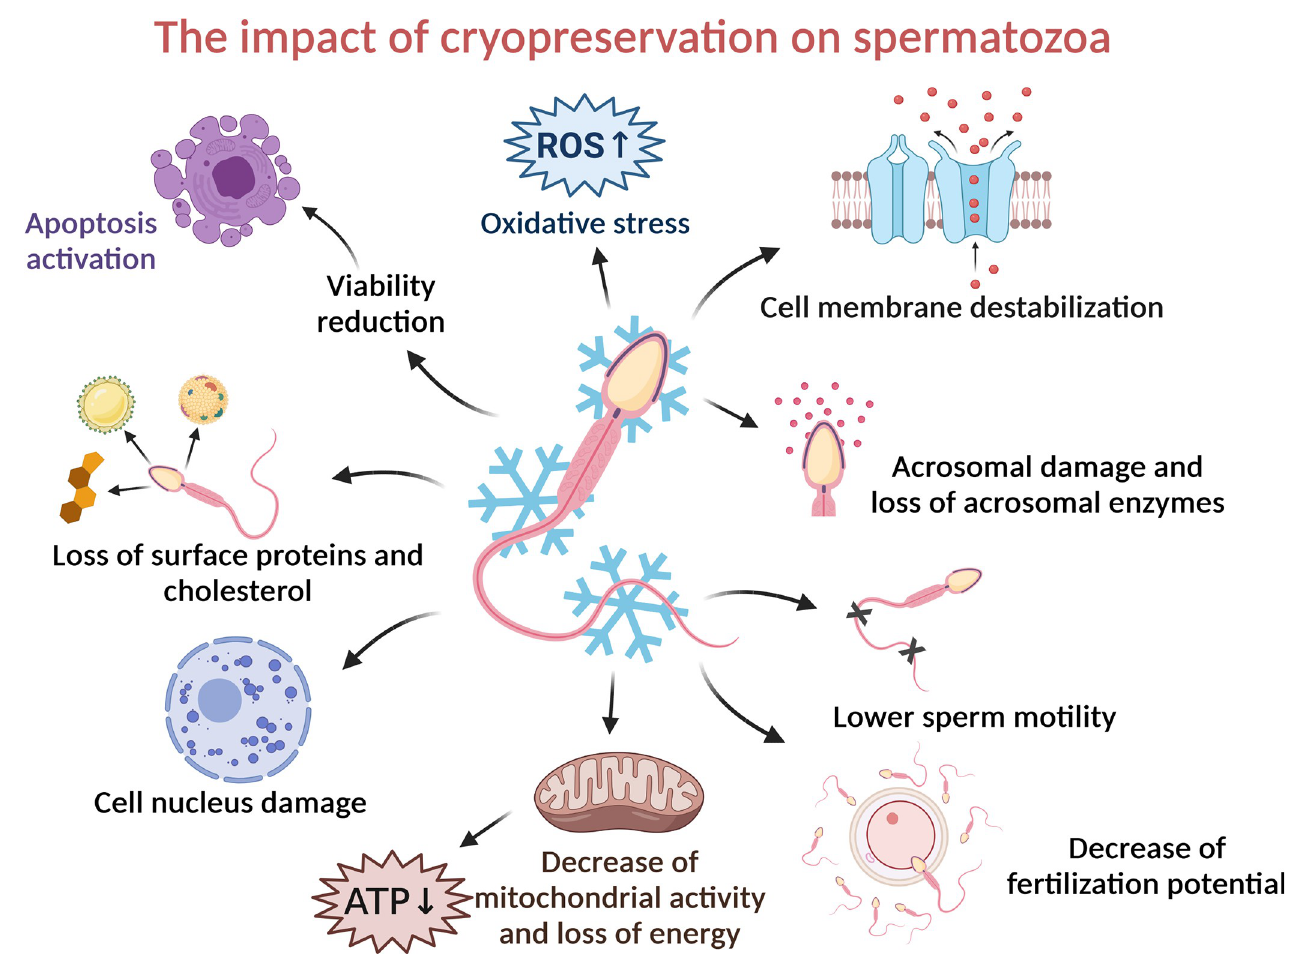
Fig 1. Consequences of cryodamage on spermatozoa including structural, functional, and molecular changes. Created with BioRender.com.